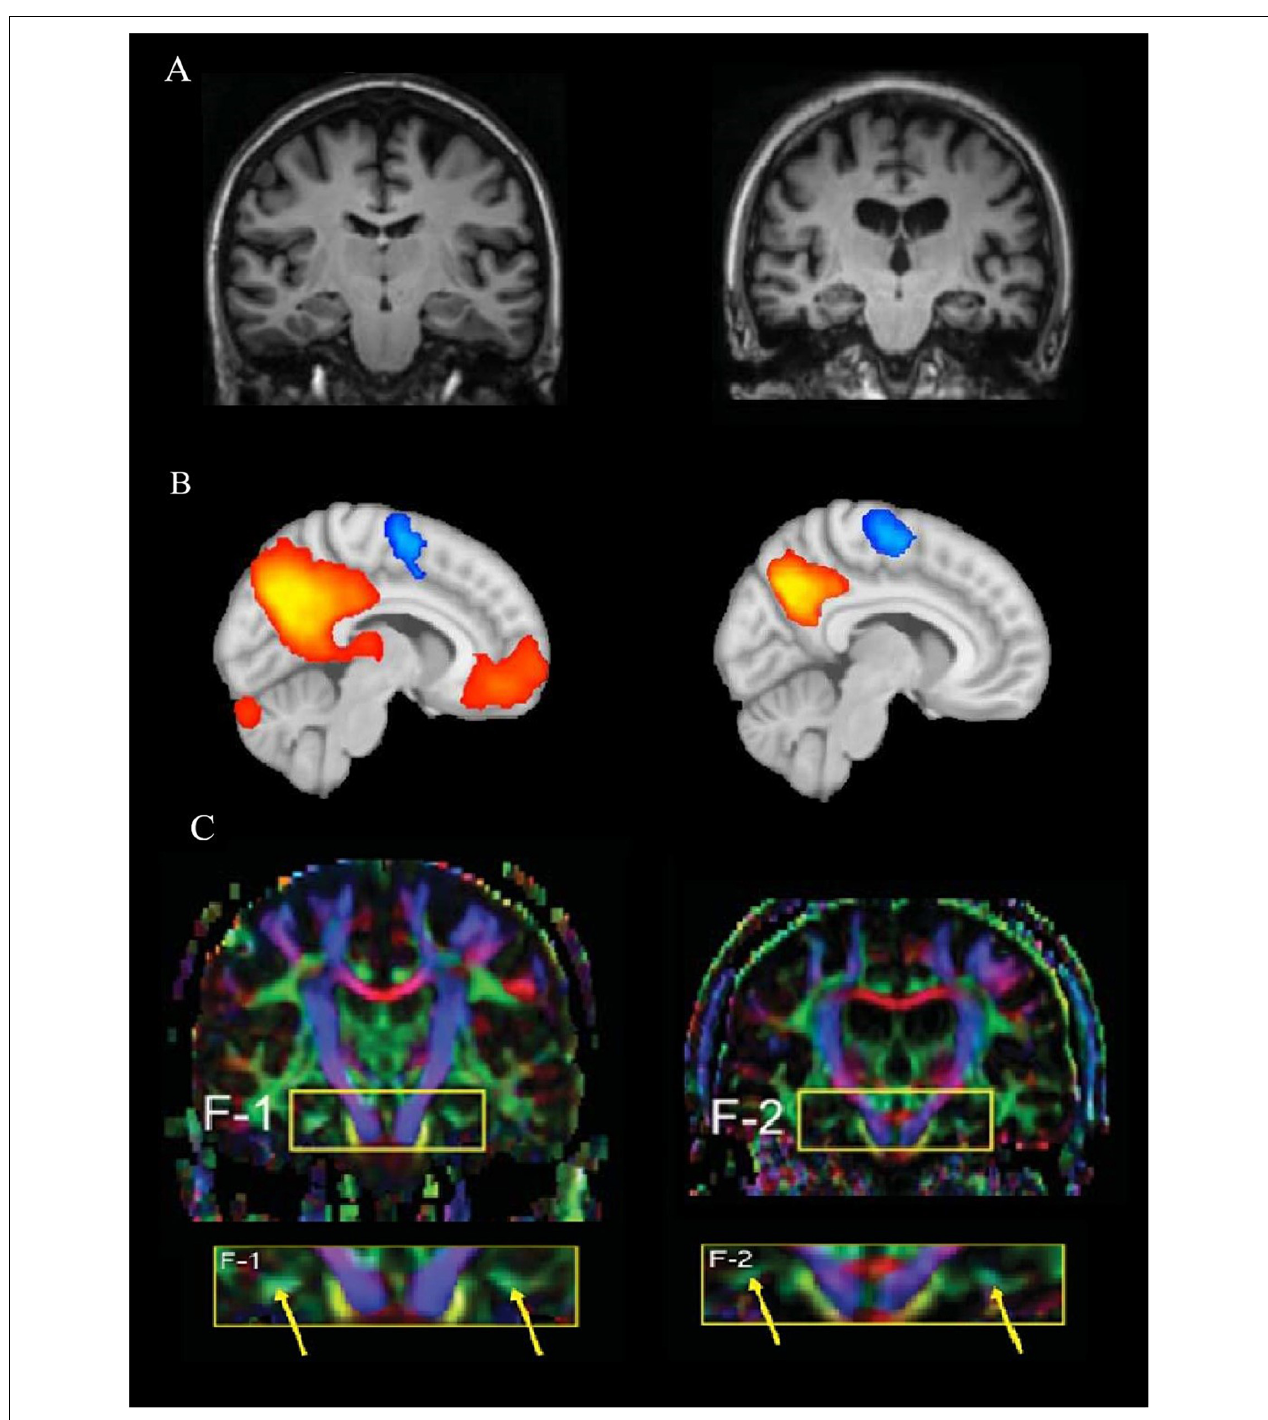
FIGURE 1 | Differences among the imaging techniques, MRI, fMRI, and DTI. (A) A structural MRI comparison between a healthy human brain (left) compared to pathological changes in Alzheimer’s disease (AD, right; Oishi et al., 2011). (B) A functional MRI representing brain activation of a resting-state network in a healthy brain (left) compared to a hypothetical AD brain activation (right). The representation of the connectivity map shows how brain activity decreases with pathology within the default mode network (DMN); red/orange represents higher connectivity, while blue represents inversely correlated activity. (C) A comparison between a cognitively healthy woman (72 years old, left) and a woman with AD (70 years old; Oishi et al., 2011). The yellow arrows show the different color strength of the cingulum hippocampal area after DTI analysis. (A,C) Reprinted from Oishi et al. (2011) with permission from IOS Press. The publication is available at IOS Press through https://content.iospress.com/articles/journal-of-alzheimers-disease/jad0007.